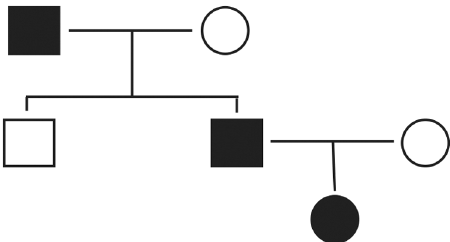
Fig. 1 Pedigree of a Chinese family with three members diagnosed with BD. In this pedigree, family relationships are indicated by lines. Squares indicate males. Circles indicate females. Filled symbols indicate affected members (with BD). Un fi lled symbols indicate unaffected/healthy members.